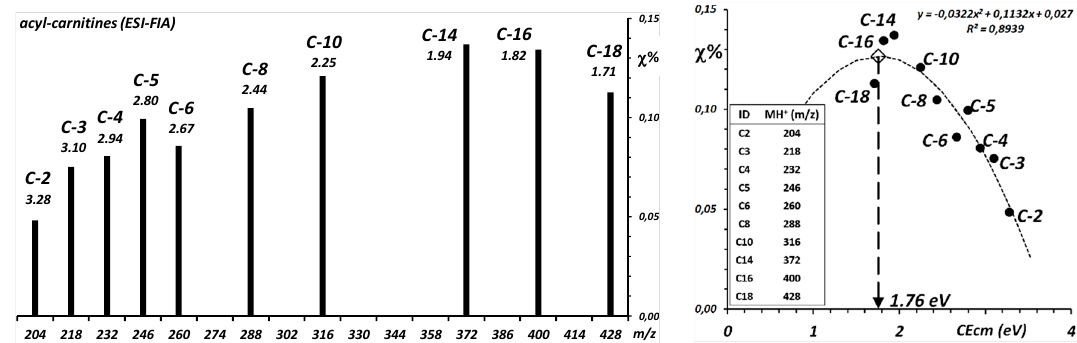
Figure 2. Re-analysis of the data from Paglia et al., 2008 (Figure 3 of ref [8]). Left: Intensities of the molecular precursors of an equimolecular mixture of acyl carnitines ionized by ESI-FIA and detected by a Precursor Ions scan of the fragment at m / z 85. Above each bar is the CE cm calculated for the precursor ion at 40 eV of CE lab on an Ar gas target, calculated from Equation (1). Right: Estimation of the fragmentation efficiency curve for the formation of the m/z 85 fragment by least squares fit to a parabolic curve.